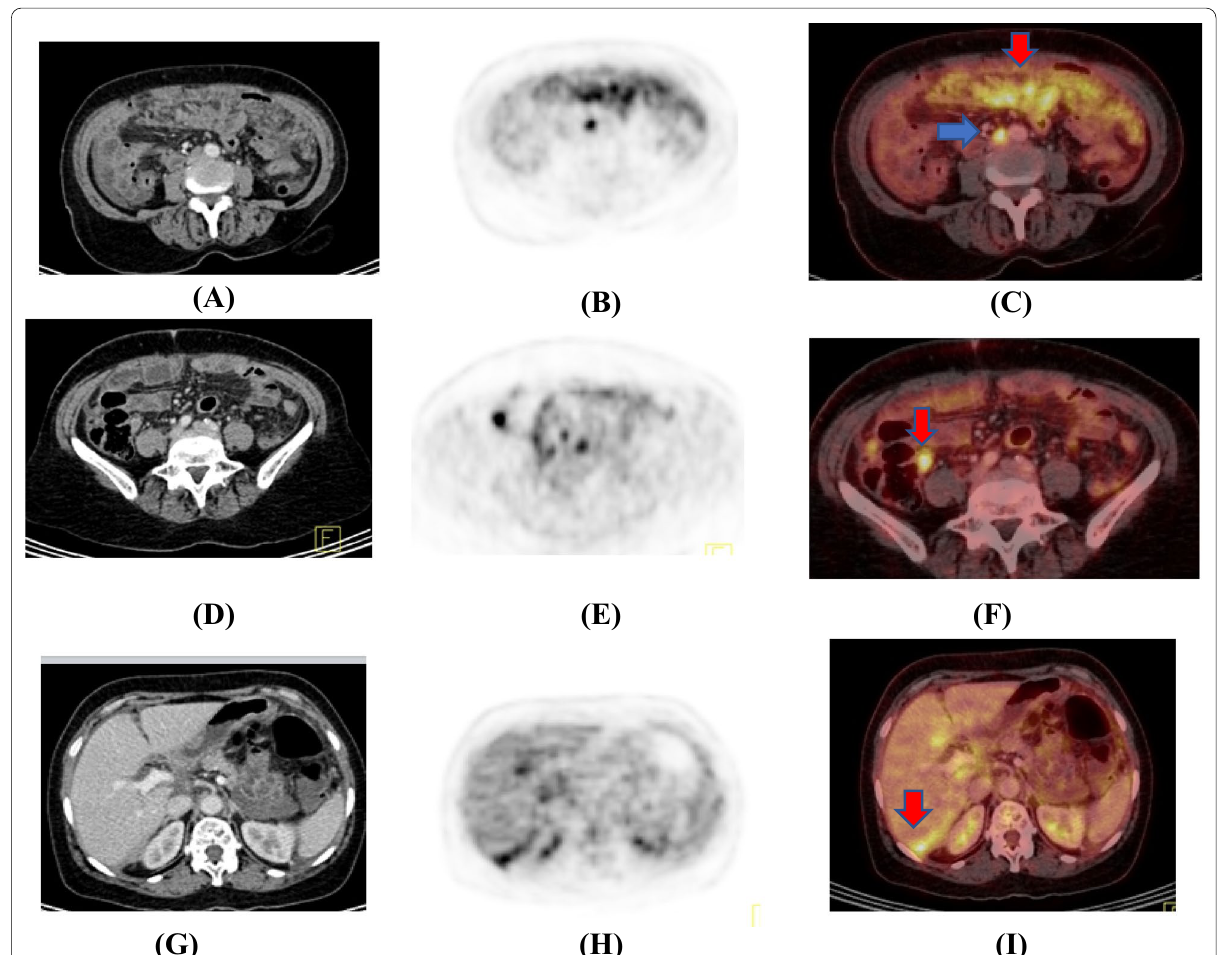
Fig. 3 A – C Axial CT, PET and PET/CT showing FDG avid right para‑aortic lymph node (blue arrow) measuring 1 cm with SUVmax 4.3, and anterior abdominal wall omental deposits (red arrows). D – I Axial CT, PET and PET/CT showing multiple nodular peritoneal/omental metabolically active deposits.These peritoneal nodules shows variable FDG uptake that is more obvious at peri‑hepatic area measured up to 3 cm with SUV max